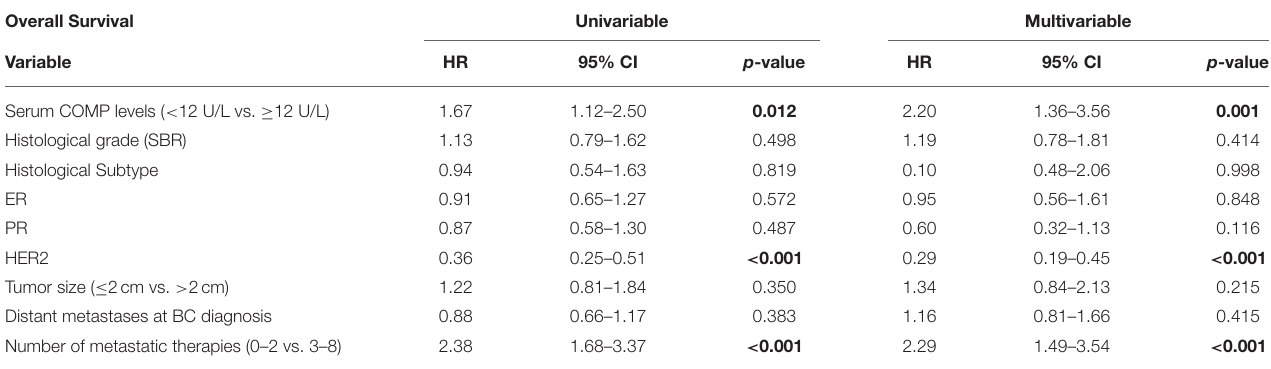
TABLE 3 | Cox univariable and multivariable survival analyses in the metastatic breast cancer patient population. Overall Survival